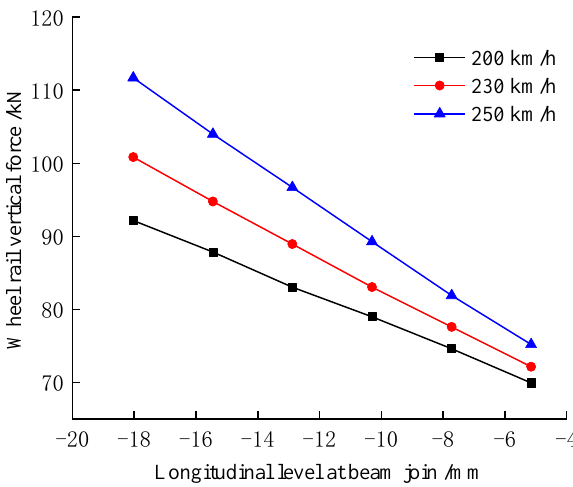
Figure 21. Wheel – rail vertical force. Figure 21. Wheel–rail vertical force.